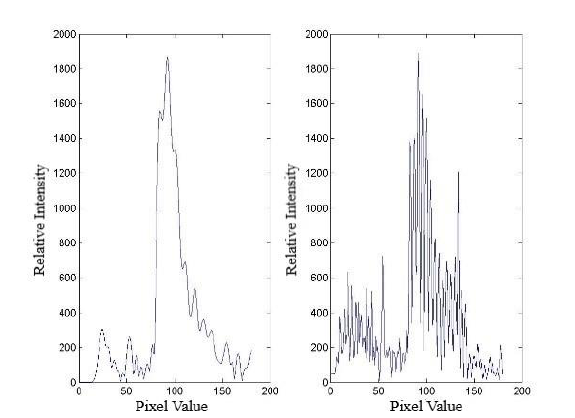
Figure 9. Fourier transform of small bilateral interference data and zero sampling interference data